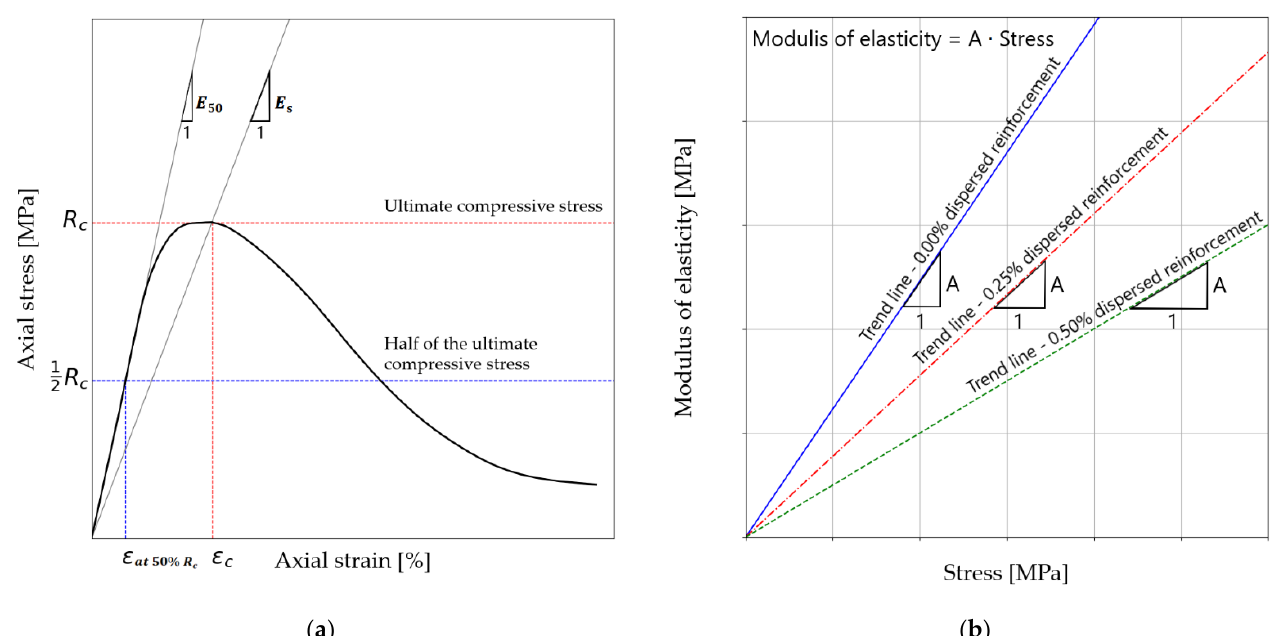
Figure 4. ( a ) Elasticity modules under consideration; ( b ) linear relationship scheme showing the effect of dispersed reinforcement.